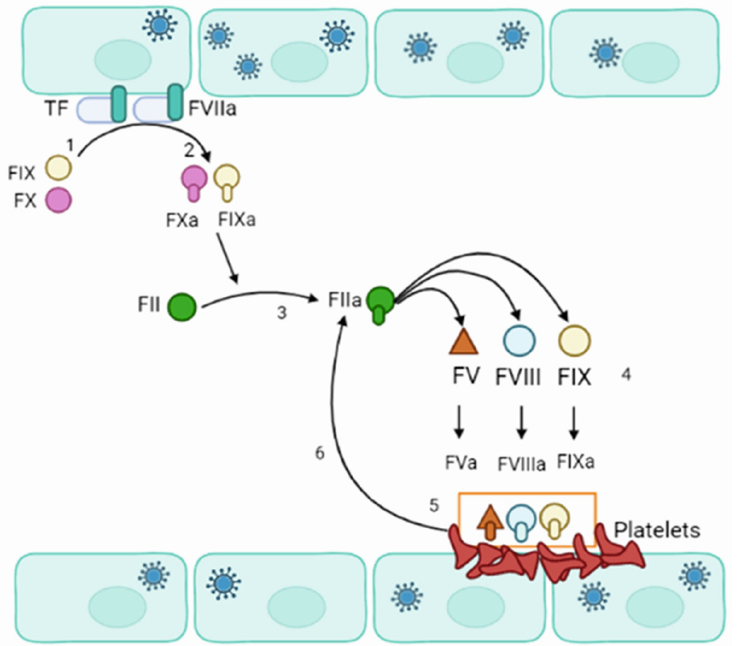
Figure 4. Schematics of orthohantavirus effect on blood coagulation. (1) Orthohantavirus-infected endothelial cell express TF. (2) TF interacts with active FVII (FVIIa) and calcium to convert FIX and FX to active IXa and Xa, respectively. FXa binds to factor II to form the thrombin (FIIa). (3) Thrombin interacts with FV, FVIII, and FXI. (4) Thrombin activates FV, FVIII, and FXI, forming FVa, FVIIIa, and FXIa. (5,6) FVIIIa forms a complex with FVa and FXa, which acts as a prothrombinase and accelerates the formation of thrombin (FIIa).